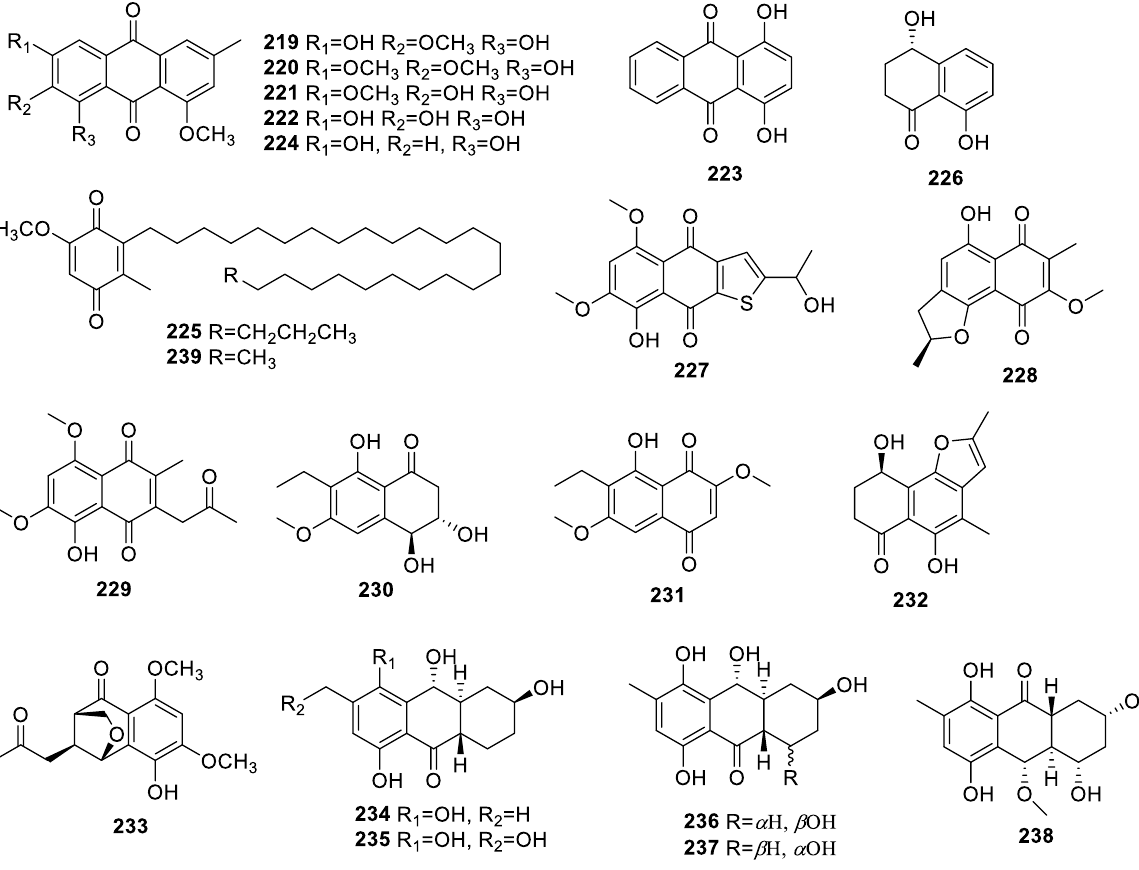
Figure 9. Chemical structures of quinones ( 219 – 239 ).